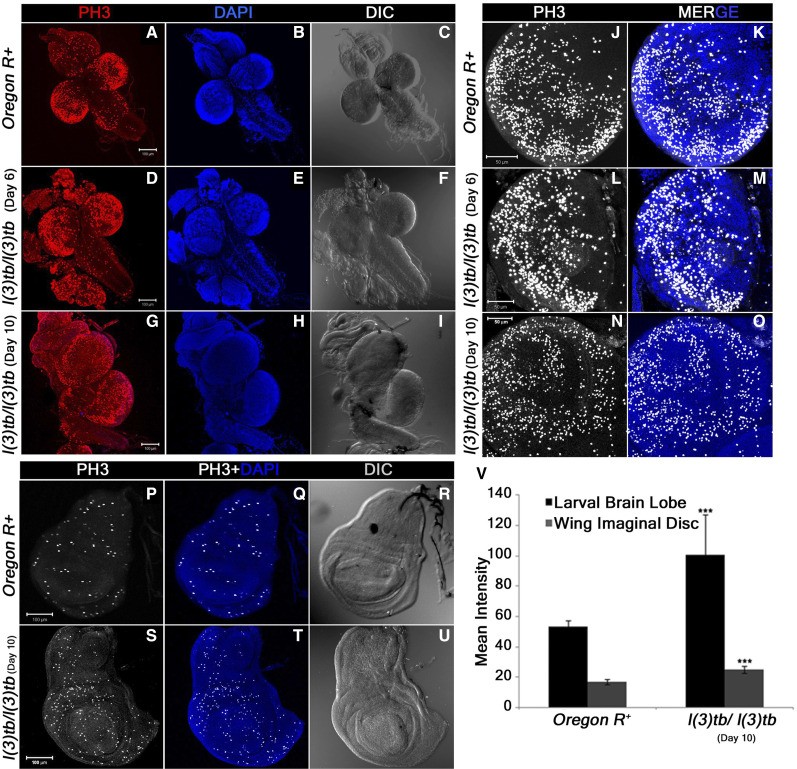
Tumorous tissues in l(3)tb homozygotes show enhanced mitotic potential. Enhanced mitotic potential observed in the tumourous tissues of homozygous l(3)tb as shown in larval whole brain (A), brain lobes (D, G) and wing imaginal discs (S) immunostained for PH3, a potent mitotic marker. Distribution of PH3 labeled cells counter stained with DAPI cells in wild type (A) and homozygous l(3)tb (Day 6 and Day 10) larval brain (D, G) and also in wild type brain lobes (B, C) and homozygous mutant brain lobes (E, F for day 6; H, I for day 10) indicated high mitotic index as compared to wild type. Similarly, more mitotic positive cells were seen in tumorous wing imaginal discs (day 10) of homozygous mutant l(3)tb (S) as compared to wild type, Oregon R+ (P) . DIC images (C, F, I and R, U) illustrate external normal morphology in wild type and more pronounced tumorous phenotypes in homozygous l(3)tb larval brain and wing imaginal discs. Quantitative analysis showed increase in the number of mitotic positive cells in homozygous mutant larval brain lobes and wing imaginal discs as compared to wild type and the difference was highly significant (V). The images are projections of optical sections acquired by confocal microscopy. Staining was done in triplicates with 10 brains and 15 wing imaginal discs in each group. Significant difference is represented as *** P ≤ 0.005 using one-way ANOVA.